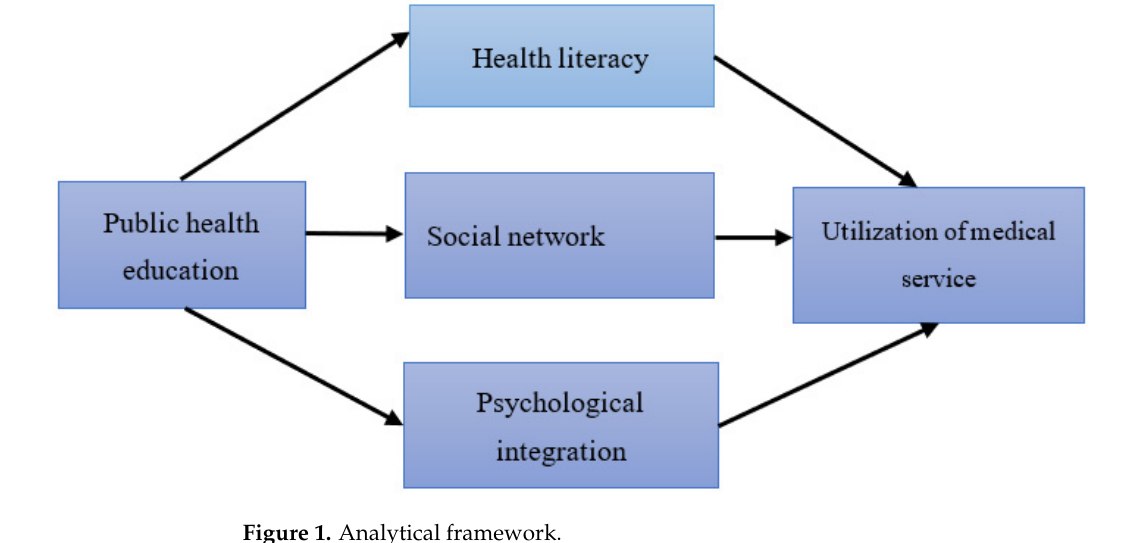
Figure 1. Analytical framework.